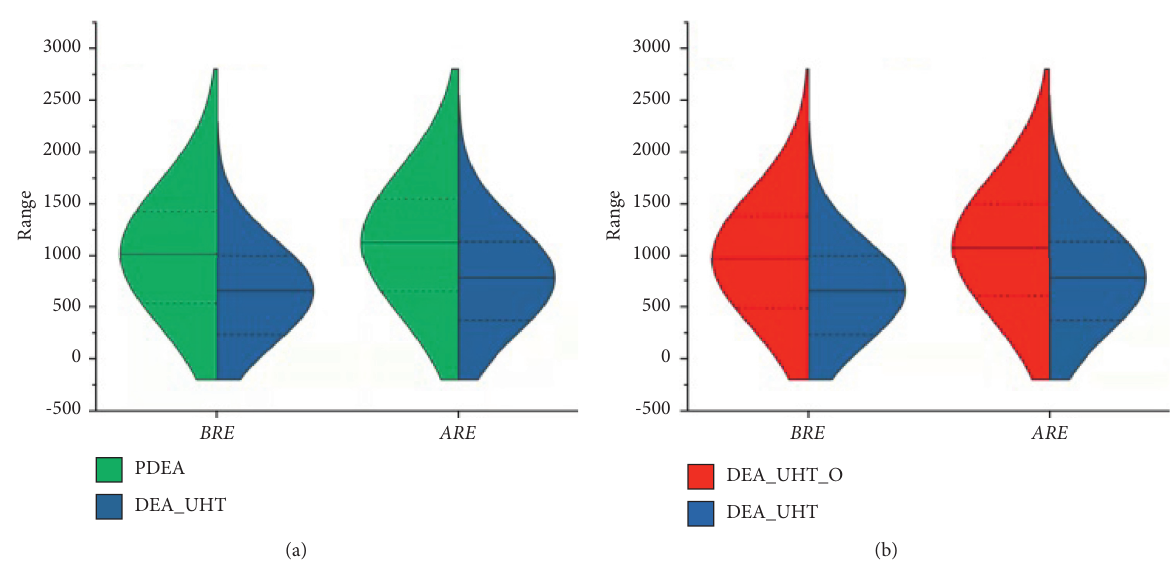
Figure 1: Violin plots for comparison results in Table 1. (a) PDEA vs DEA_UHT. (b) DEA_UHT_O vs